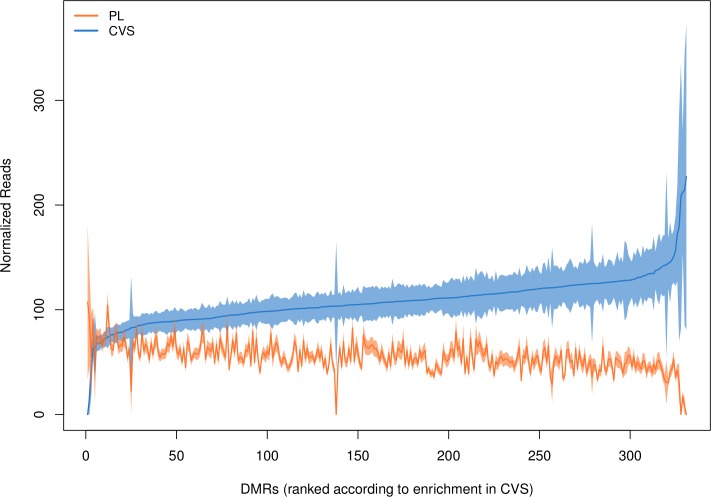
Methylation enrichment profile for all DMRs on CVS and female non-pregnant plasma samples.The DMRs are presented in the x-axis in order of increasing methylation in CVS. The blue line shows the mean enrichment in CVS (n = 29) for each DMR and the orange line the mean enrichment of each DMR in the plasma (n = 27). The shaded area around the mean shows the distance of plus and minus one standard error from the mean. Analysis indicated that the difference is statistically significant (p<0.001) in 313 out of 331 DMRs.